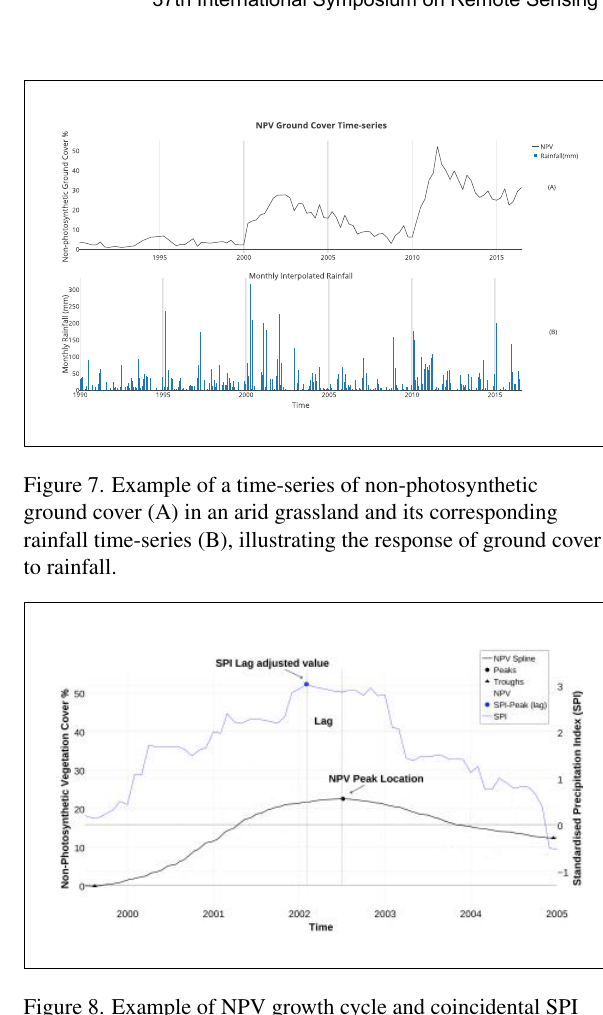
Figure 8. Example of NPV growth cycle and coincidental SPI time series. The NPV growth peak (black circle) and its lag or offset to the SPI time series (vertical dashed lines) is illustrated.